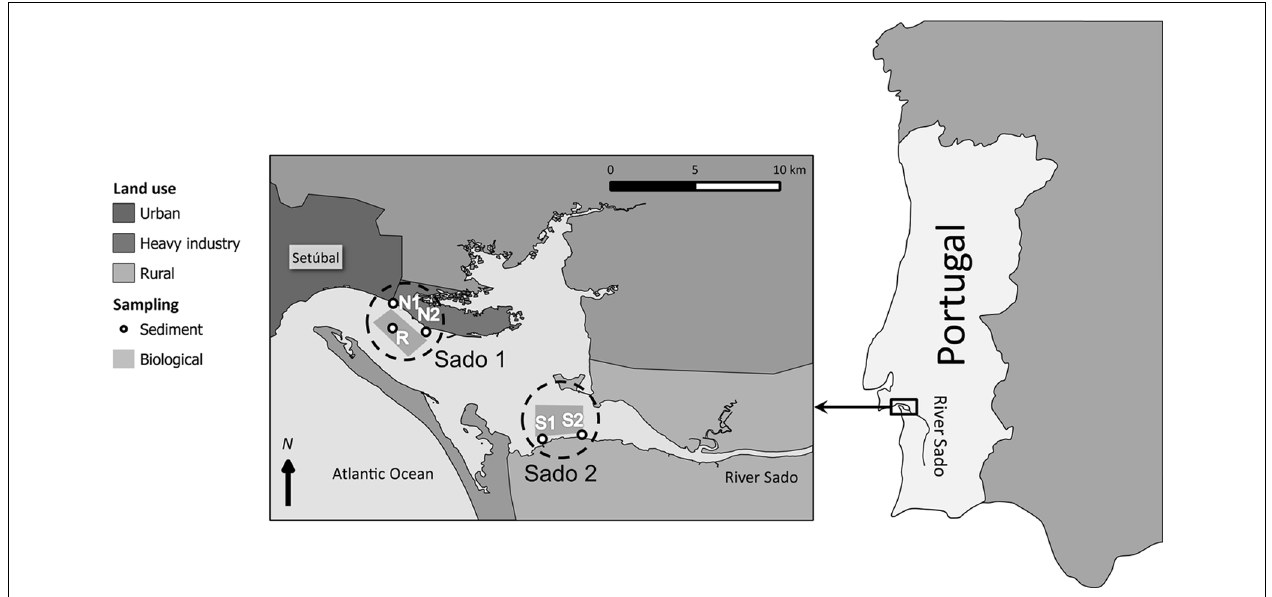
FIGURE 1 | Map of the river Sado Estuary, Portugal, highlighting the two study areas: Sado 1 (north) and Sado 2 (south). Sediment collection sites and organism fishing grounds for each area are also indicated. Refer to the legend for specifics.